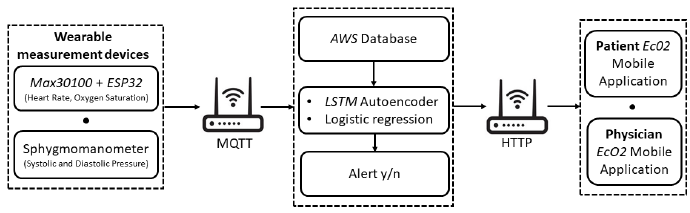
Figure 2. Implementation of the proposed telemonitoring